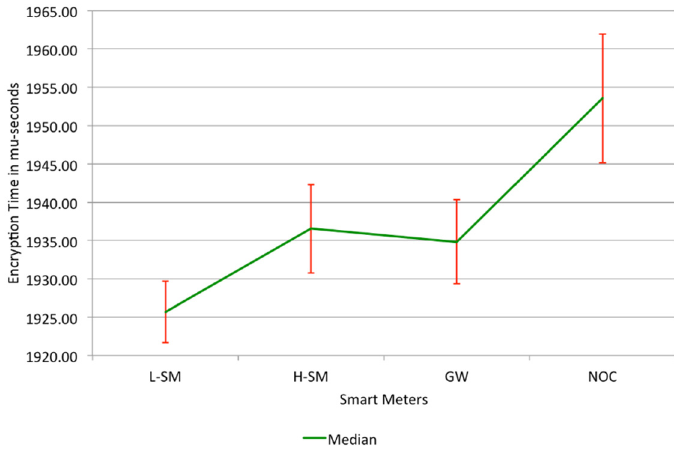
Figure 9. Time taken for AES encryption of a 16 byte block on motes in a mesh topology.